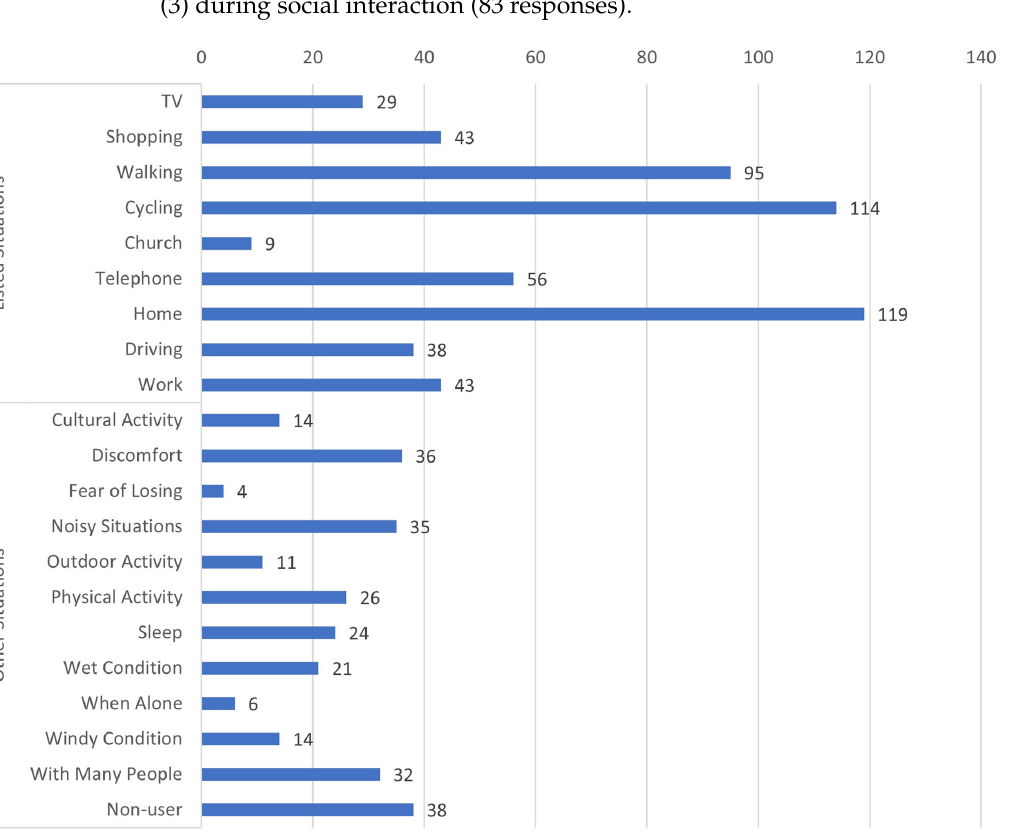
social interaction (83 responses).